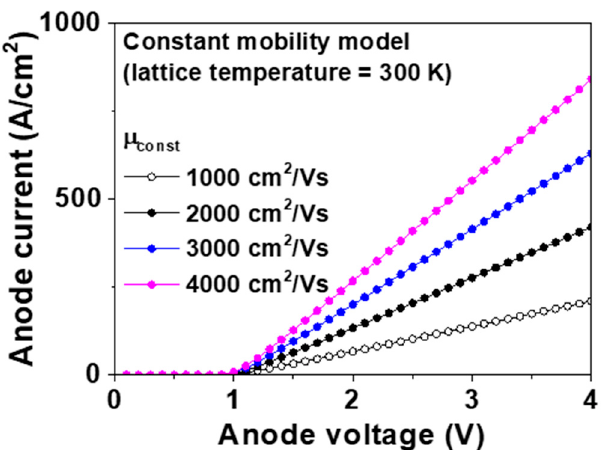
Figure 2. Forward current–voltage (I–V) characteristics of the p-type diamond pseudo-vertical Schottky barrier diode (SBD) simulated using the constant mobility model at 300 K. The values of µ const were 1000, 2000, 3000, and 4000 cm 2 / Vs, respectively. The metal work function, hole saturation velocity, and lattice temperature were 5.65 eV, 2.7 × 10 7 cm / s, and 300 K, respectively. Table 1. Hole mobility, forward voltage drop ( V f ), and specific on-resistance ( R on,sp ) of the p-type diamond pseudo-vertical Schottky barrier diode (SBD) simulated using the constant mobility model with μ const of 1,000, 2,000, 3,000, and 4,000 cm 2 /Vs. The lattice temperature was 300 K.